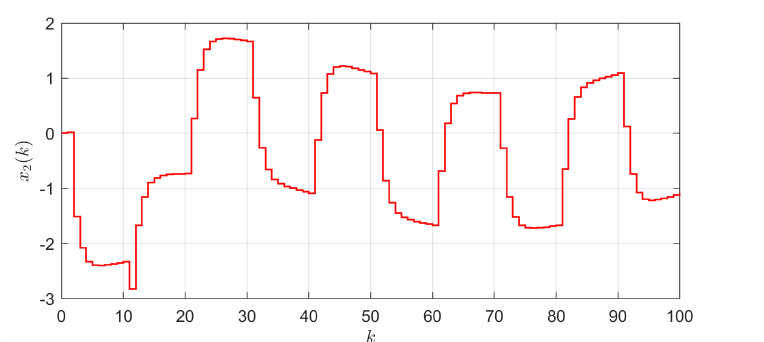
Figure 7. First state variable.